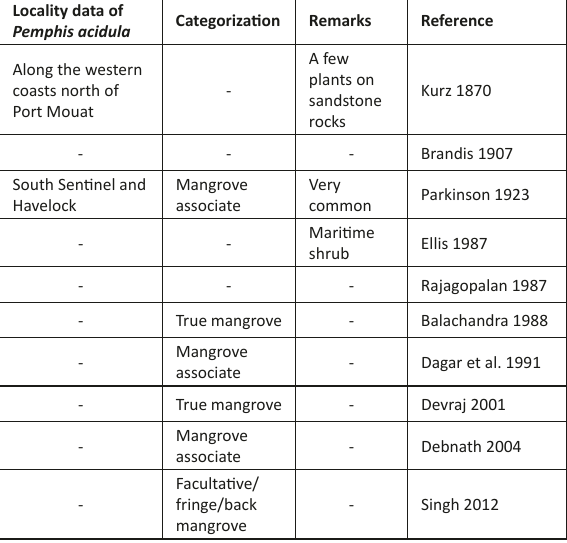
Table 1. Pemphis acidula J.R. Forst. & G. Forst. in Andaman and Nicobar Islands according to 10 published literatures from 1870 to 2012. ‘-’ denotes details not